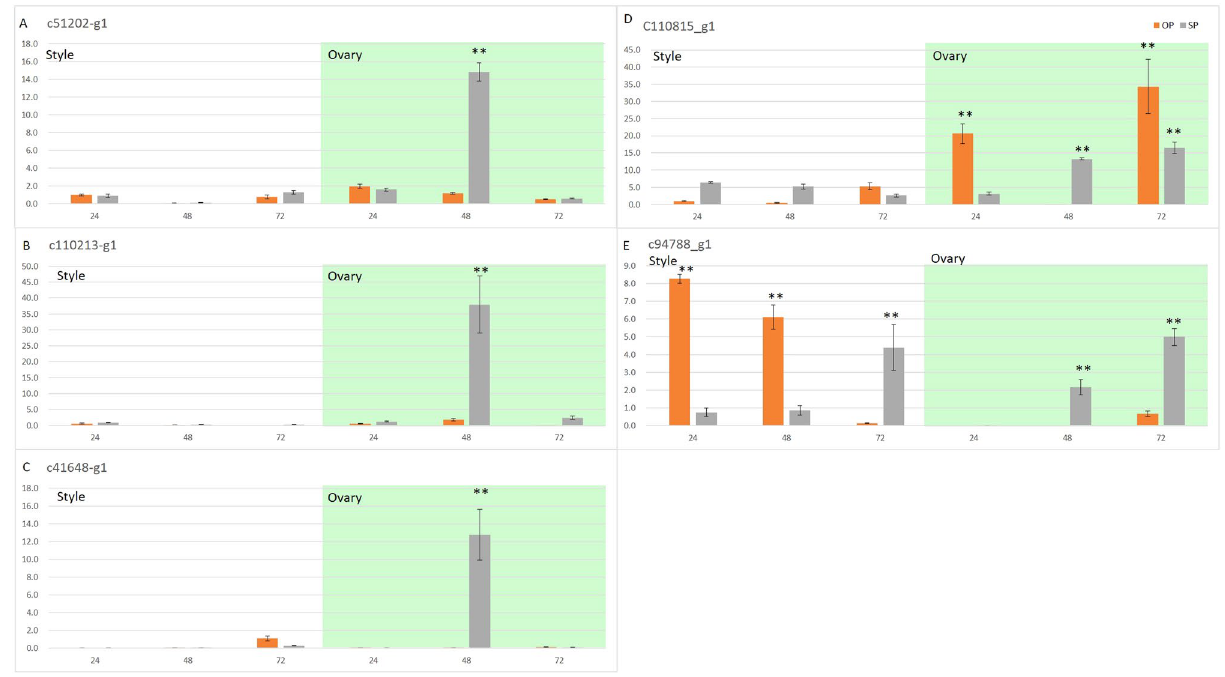
Figure 9. qRT-PCR expression analysis of 3 SFB genes ( A – C ) and 2 S-RNase ( D , E ) using GAPDH as the internal control from 24 to 72 h in the style and ovary of SP and OP. ** p values